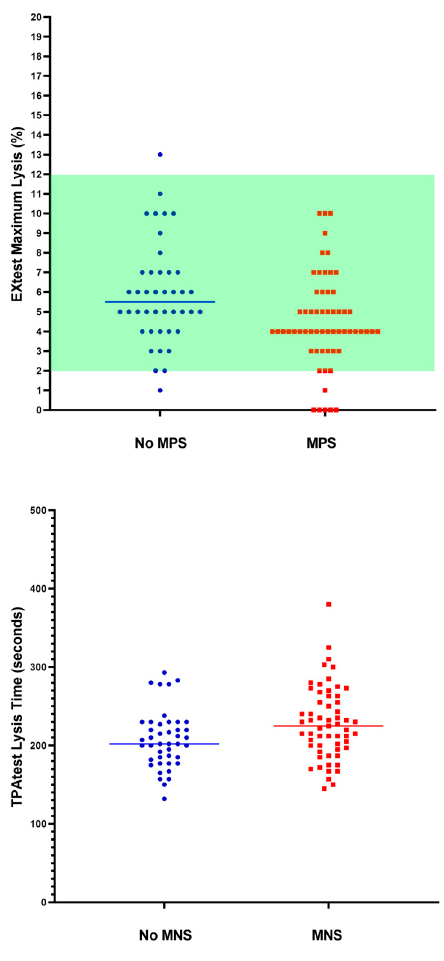
Figure 4. Individual and mean values of fibrinolysis according to the presence of major physical symptoms (MPS) and major neurological symptoms (MNS). Green area is the normality range. No defined normal range exists for TPAtest.